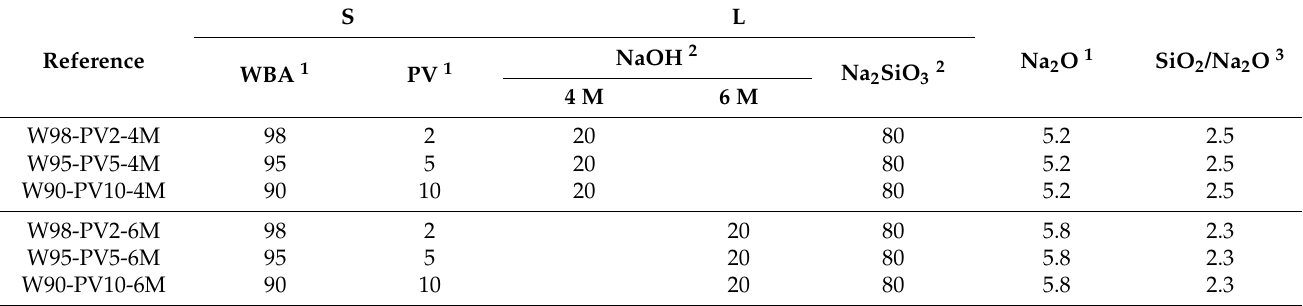
Table 2. AA-WBA/PV mix